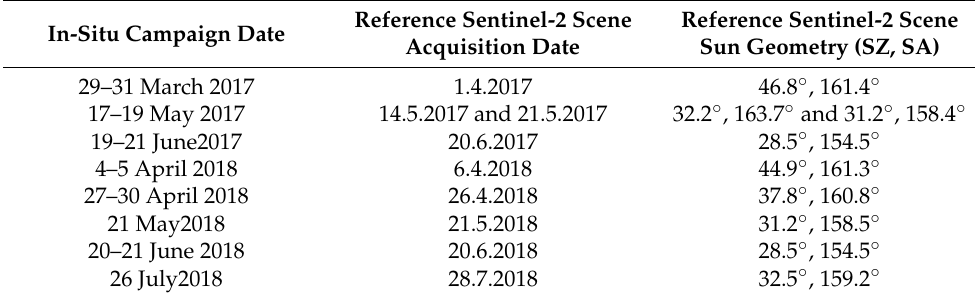
Table 3. Summary on in-situ data collection campaigns dates and the reference Sentinel-2